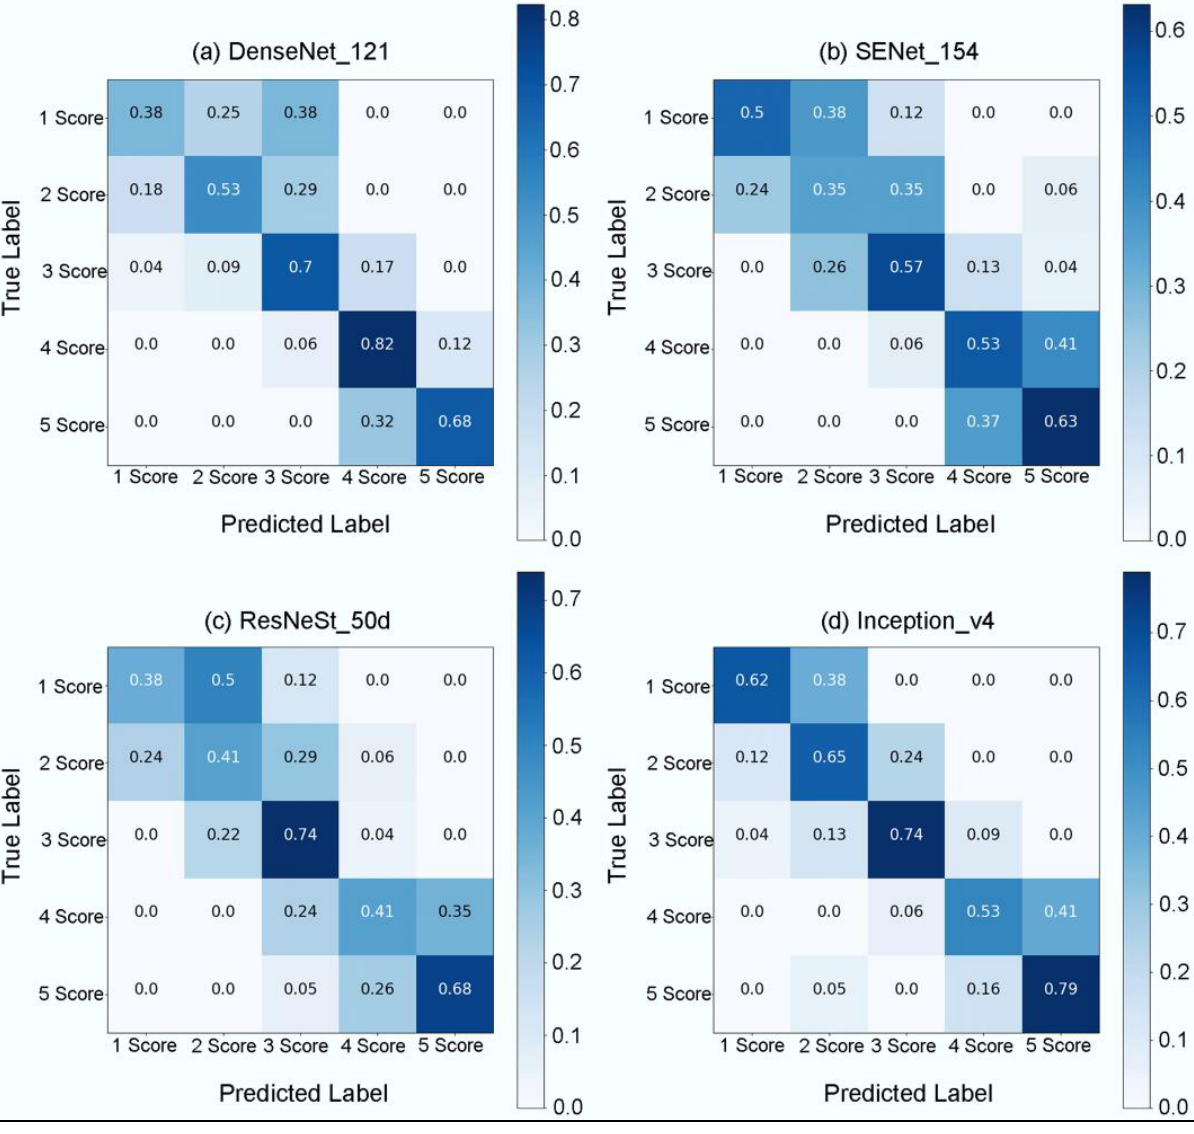
Figure 2. The test images of the normalized confusion matrices of correlations that evaluated the four networks, namely DenseNet-121 ( a ), SENet-154 ( b ), ResNeSt-50d ( c ), and Inception-v4 ( d ).